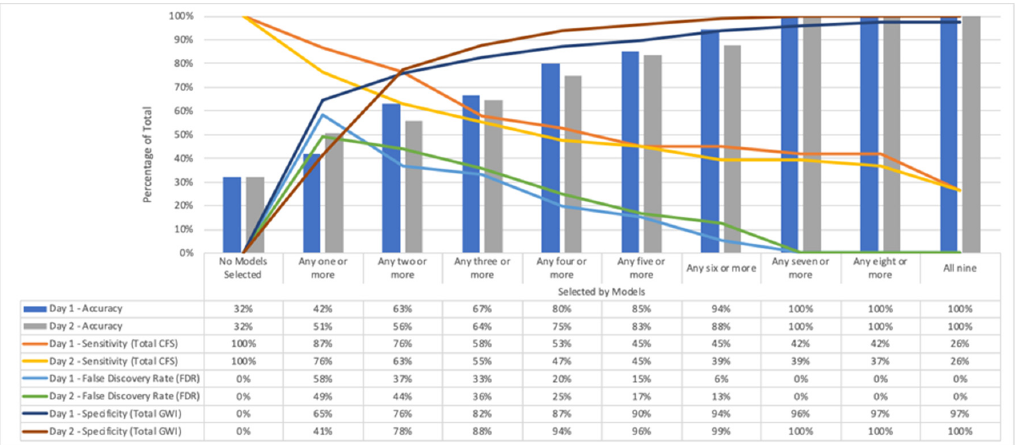
Figure 4. Histogram of feature importances based on Random Forest for all features. High error bars were coerced from a small dataset and repeated testing on various models. Features are plotted in ranked order.